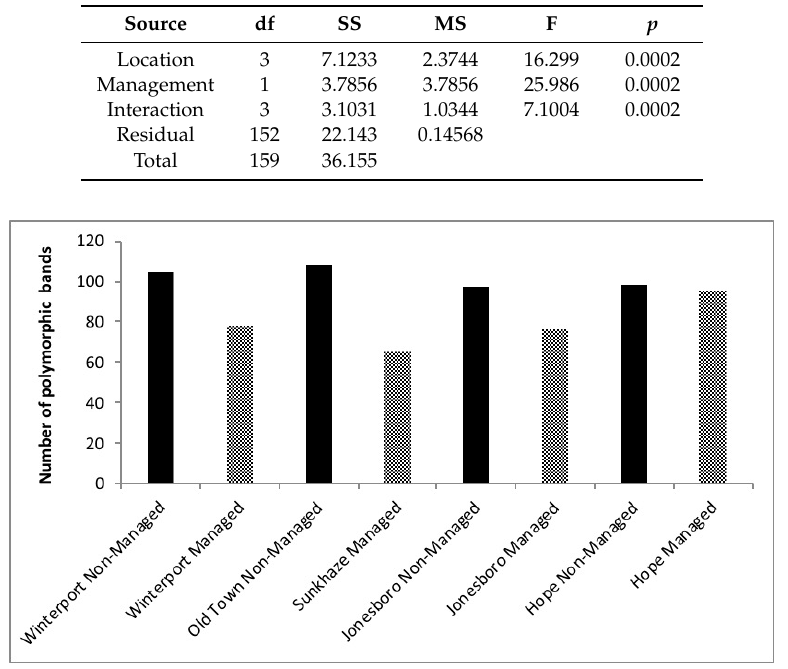
Table 3. Non-parametric analysis of variance (PerMANOVA) for paired (location) managed and non-managed population comparisons. Significant differences are found between location, management, and the interaction ( p = 0.0002), where df = degrees of freedom, SS = sums of squares, MS = mean square, F = F statistic, and p = probability of significance.